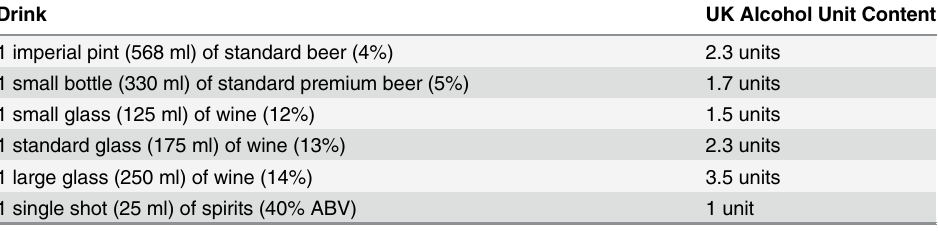
Table 2. UK alcohol unit content of popular drinks (1 unit = 8 g [10 ml] of pure alcohol). Drink